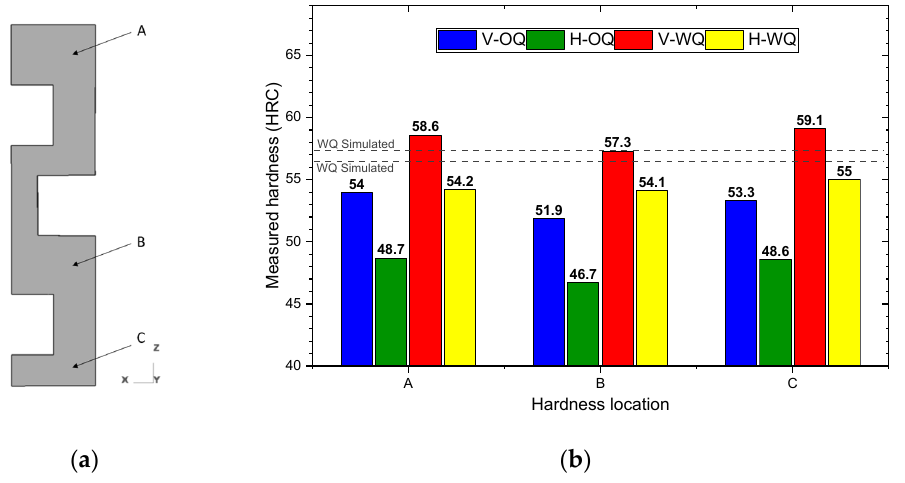
Figure 11. Measured and calculated hardness in quenched samples: ( a ) measured zones and ( b ) experimental hardness results.